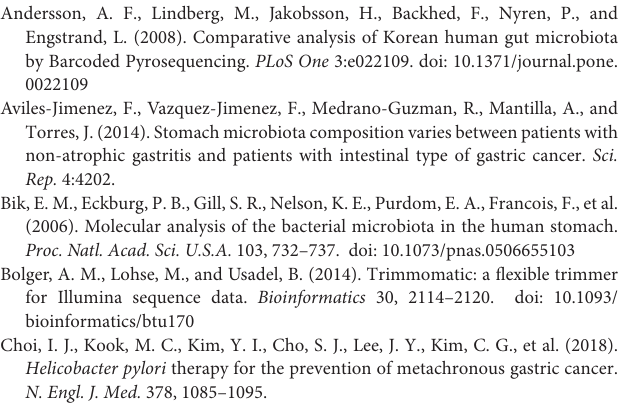
Supplementary Figure 2 | Bacterial composition of the study subjects ( N = 43) at phylum level. Supplementary Figure 3 | Relative abundance of nitrosating bacteria other than H. pylori (A) and urease-producing bacteria other than H. pylori (B) at gastric